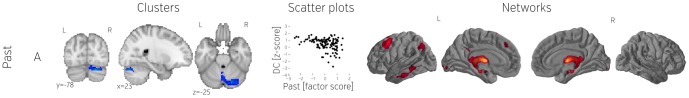
Degree Centrality cluster found using the more liberal threshold not corrected for the number of derivatives.From left to right: cluster location, scatterplot showing relation between dependent variables (mean Degree Centrality values) and contrast scores (questionnaire factors), and the network obtained by seeding with the cluster. All derivatives have been z scored. All scatterplots represents the whole population (n = 121).